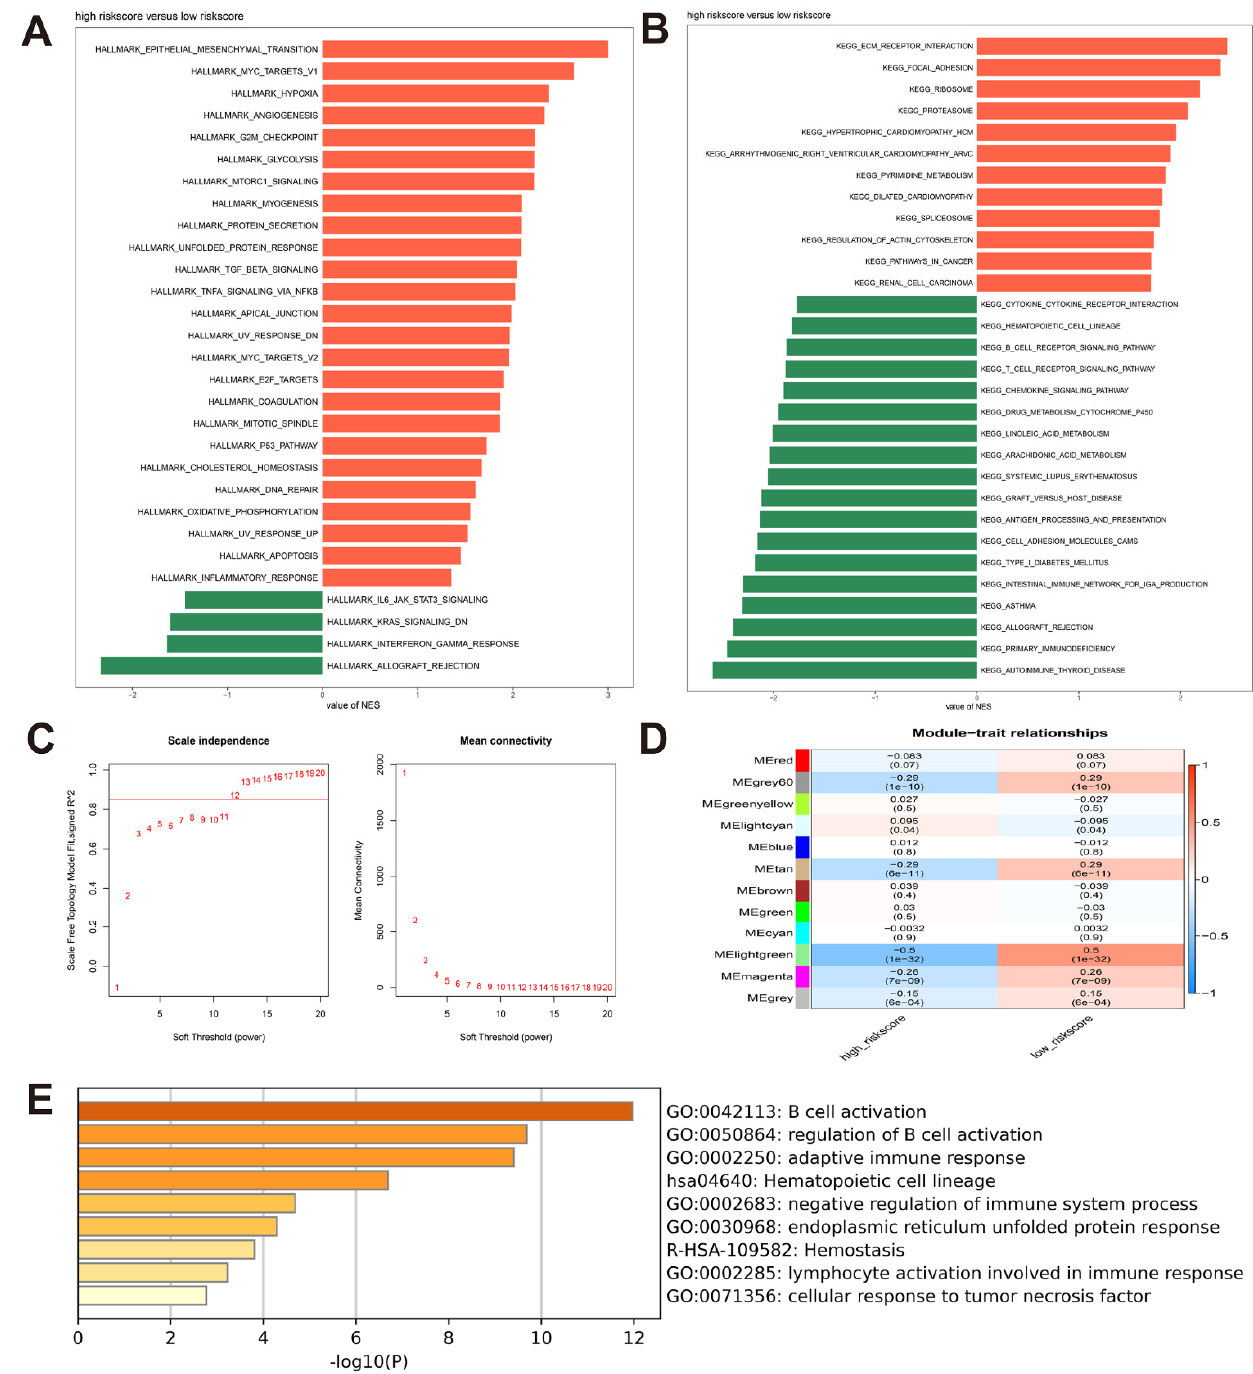
Figure 4. Identification of the risk model-associated enriched biological functions and